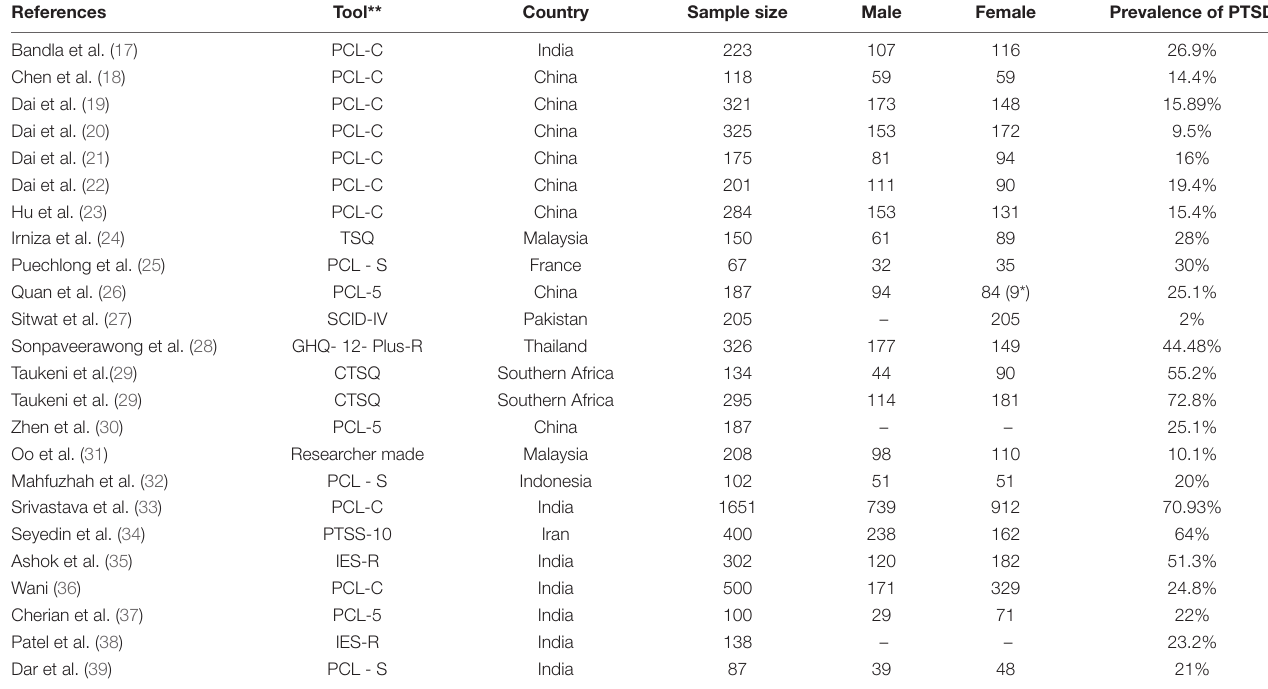
TABLE 1 | The characteristics of the selected studies in